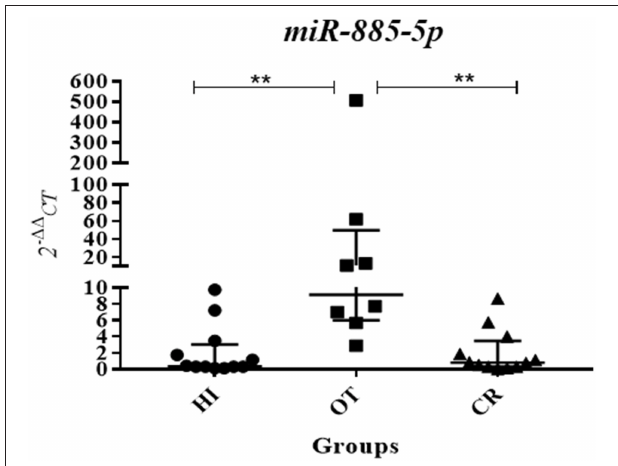
FIGURE 4 | Validation assay showing increased levels of miR-885-5p in operational tolerance. Following the detection of higher levels of miR-885-5p in OT compared to chronic rejection in the global analysis, we performed a validation experiment by individual quantitative real-time PCR, using a specific primer for miR-885-5p , in a larger number of study subjects, using individual samples (OT n = 8, CR n = 12, HI n = 12; OT, operational tolerance; CR, chronic rejection; HI, Healthy individuals). Values are expressed as 2 − 11 Ct for miR-885-5p serum levels. For the statistical calculation we used the Kruskal-Wallis method followed by the Dunns post-test, and the results were considered significant if p < 0.05. ** p = 0.0063 (OT × CR) and 0.0035 (OT ×